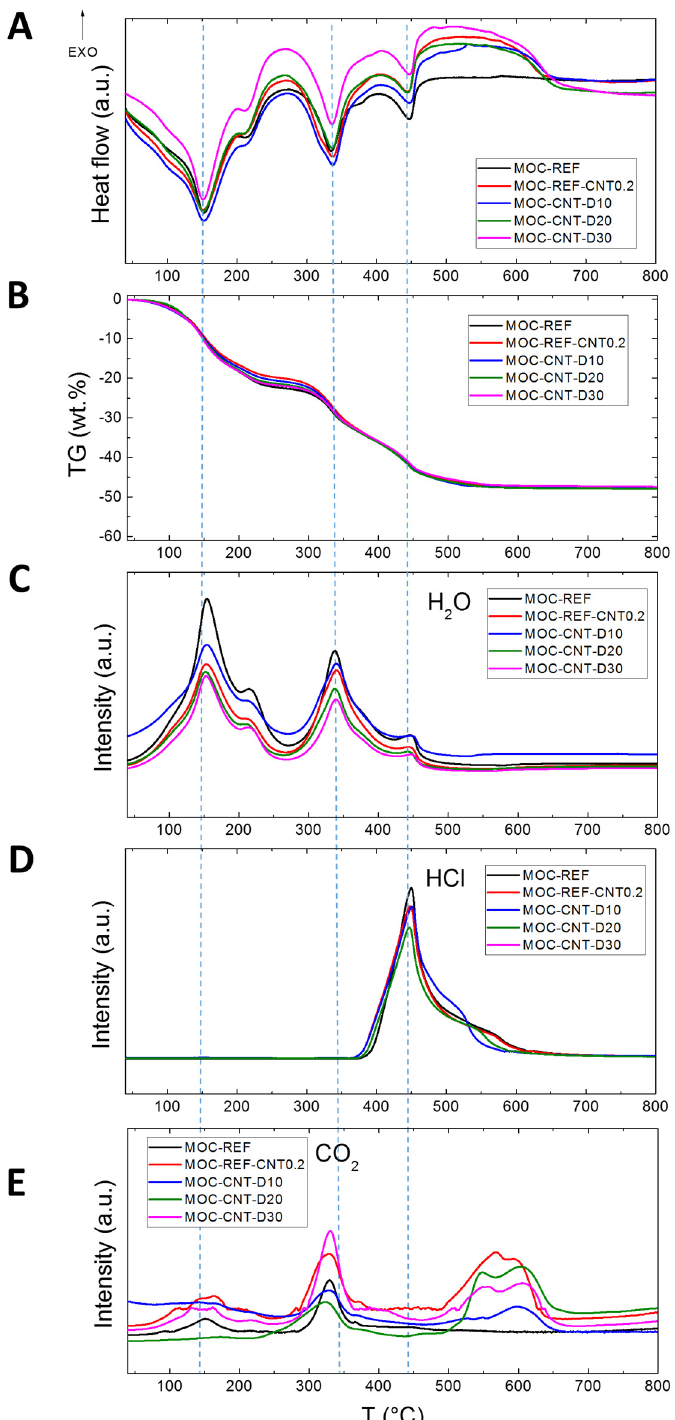
Figure 5. STA-MS of prepared composites: ( A ) DTA, ( B )TG, ( C ) MS of water, ( D ) MS of hydrochloric acid and ( E ) MS for carbon dioxide. The blue dashed line is showing the position of three major endothermic effects.